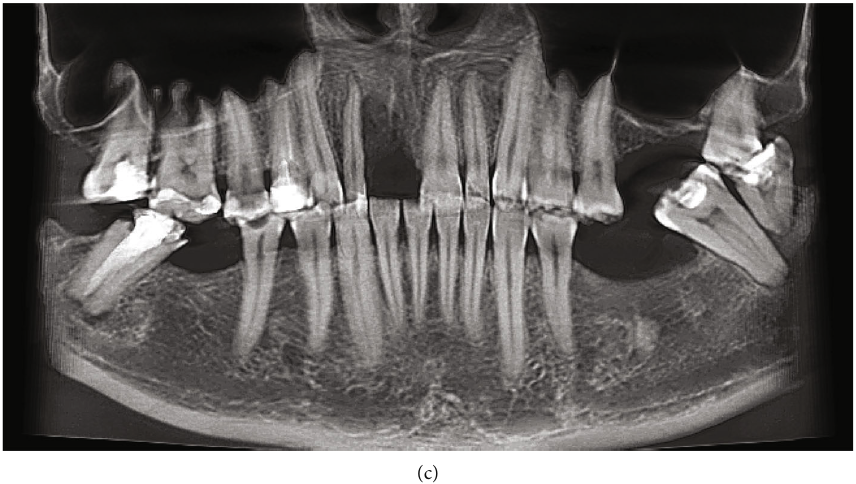
Figure 2: Cone-beam computed tomography scans obtained before the surgery.